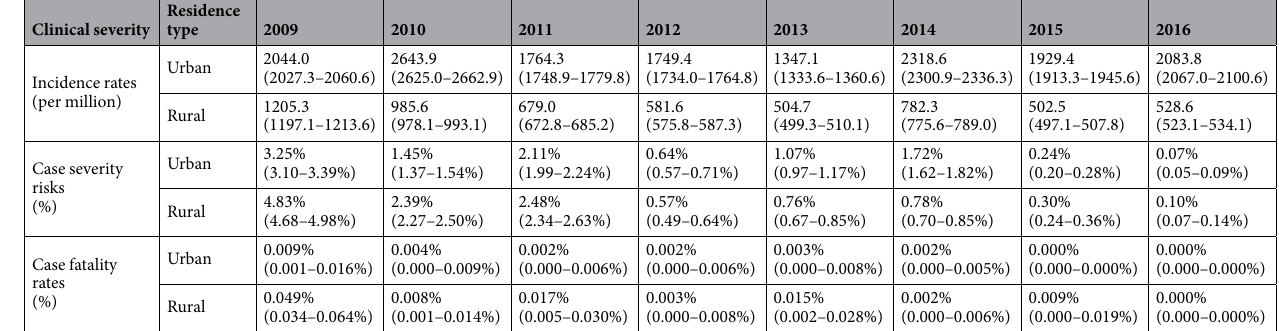
Table 4. Clinical severity and residence type of HFMD cases in Shandong province, 2009–2016.